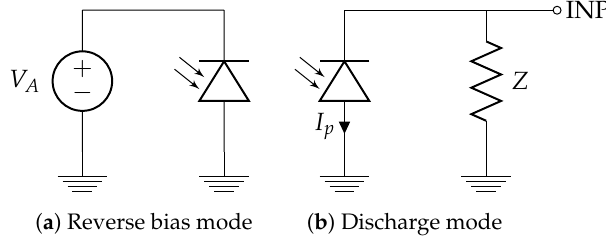
Figure 4. LED measurement phases: ( a ) the receiving LED is reverse biased by V A ; then in ( b ), switching to input mode, the time required to discharge the device through I p is evaluated by measuring the voltage on the LED, where Z represent the high impedance state of the